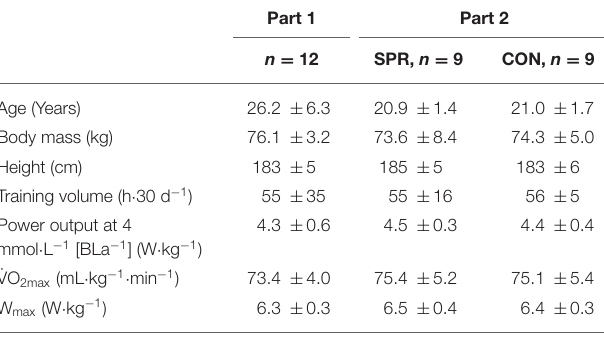
TABLE 1 | Participants’ characteristics and physiological variables determined during an incremental blood lactate profile test and incremental test to exhaustion to determine maximal oxygen consumption ( ˙ VO 2max